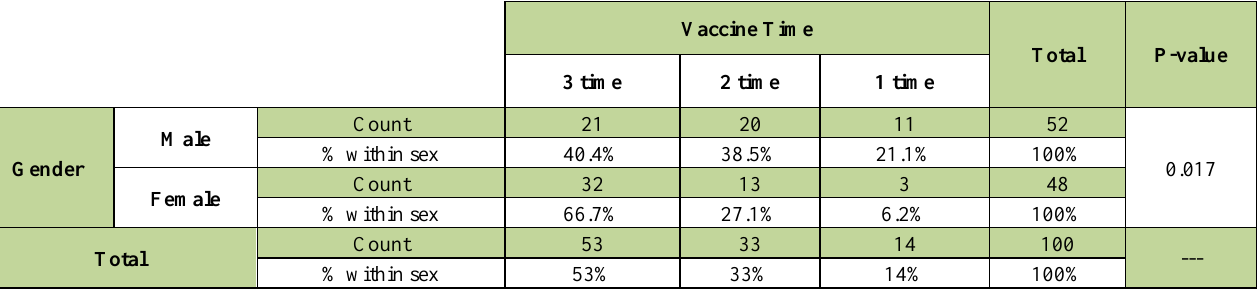
Table 3. Frequency of samples in terms of the number of doses received by